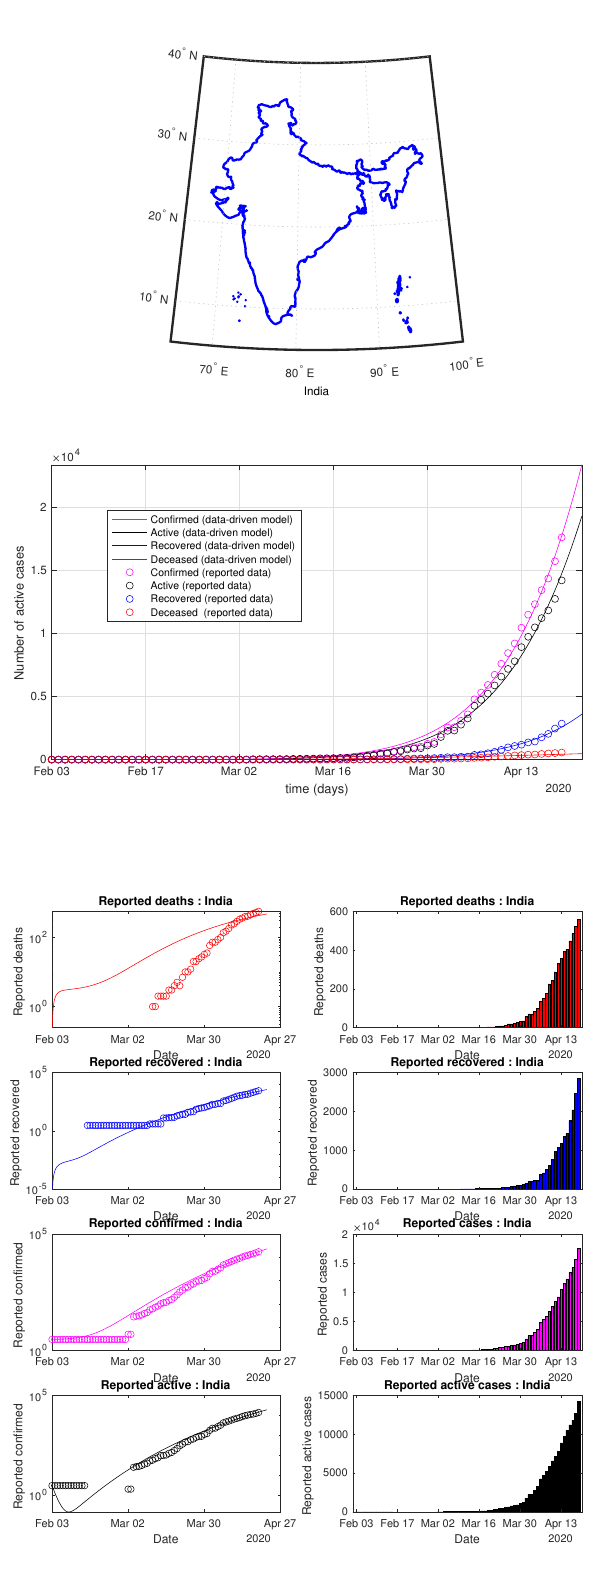
Figure 35. India: data of active, recovered, deceased (in circle or bar) vs. model of active, recovered, deceased over time. Tracking the number of active cases. Predictive analytics for the next couple